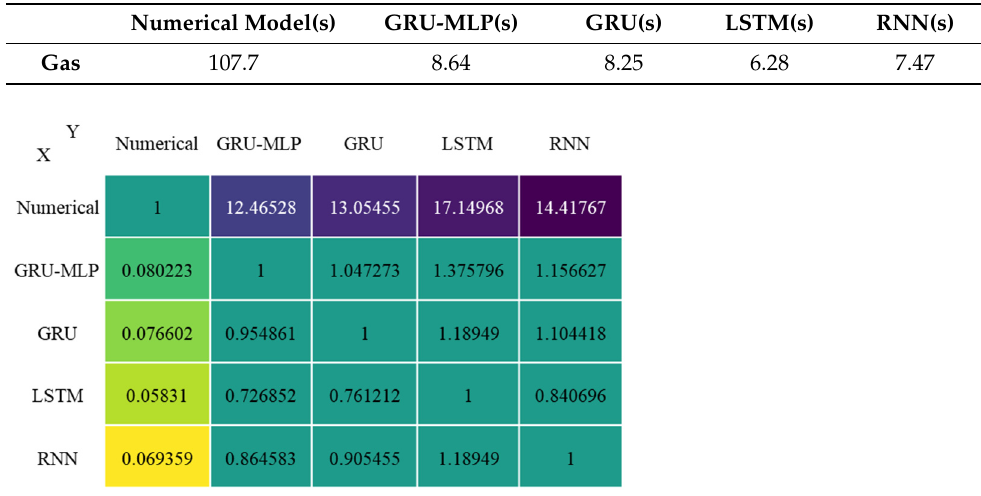
Table 3. The CPU times of different models for gas flow rate.